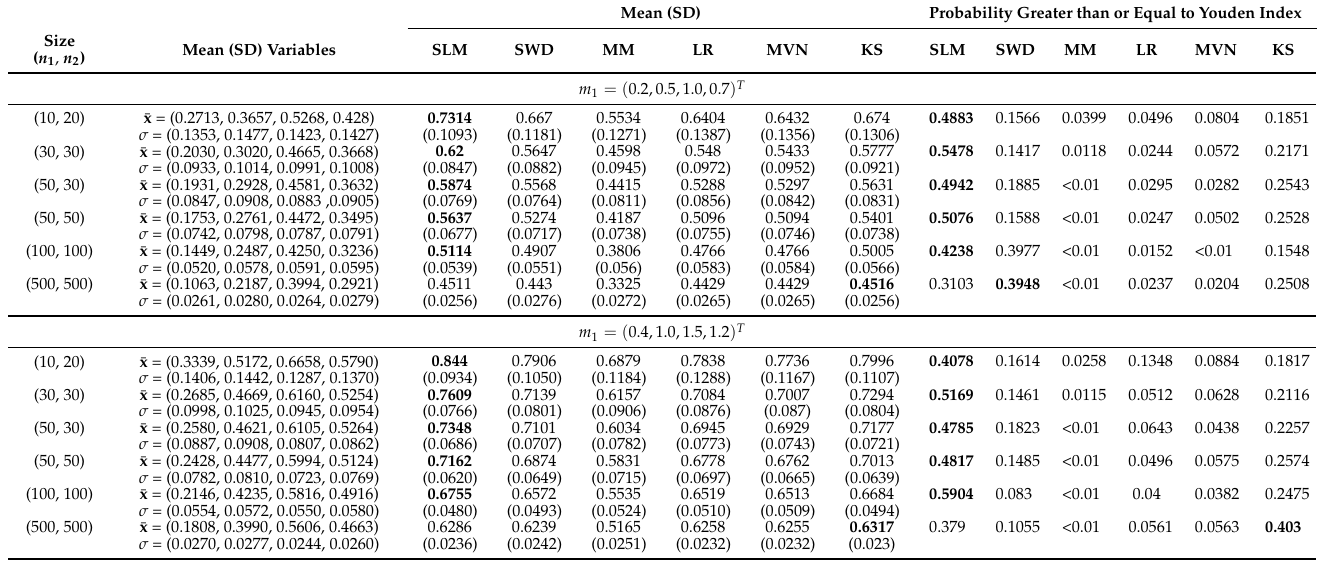
Table 3. Normal distributions: Different means. Medium correlation ( Σ 1 = Σ 2 = 0.5 · I + 0.5 · J ).